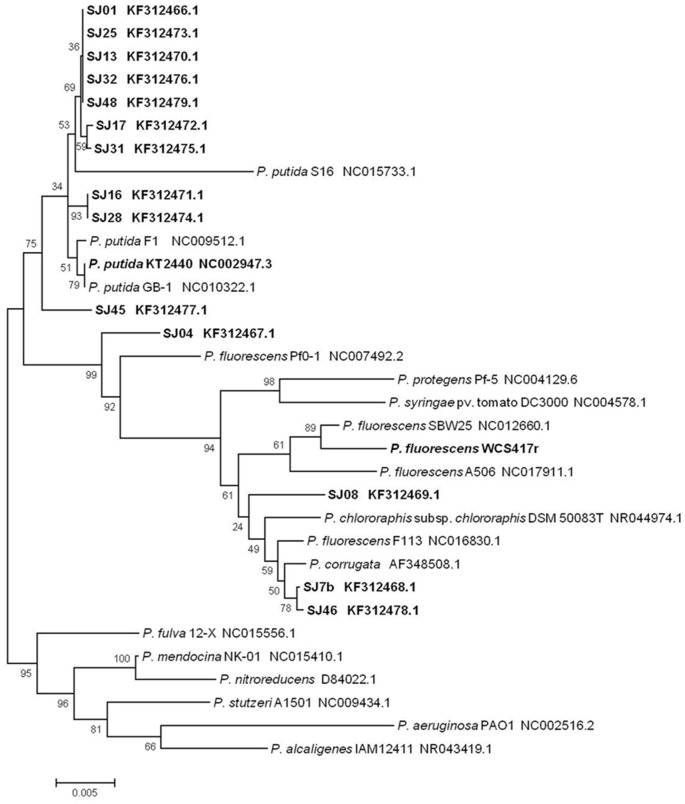
Phylogenetic tree of native and reference strains of fluorescent Pseudomonas based on aligned 16S rRNA sequences. Native strains isolated from the M. piperita rhizosphere are indicated by boldface. The tree was constructed based on multiple alignments and the neighbor-joining method, using the MEGA 4.0.2 software program. Bootstrap values on branches are shown as percentages from 1000 replications. Scale bar at bottom represents 5 nt substitution per 1000 nt sequences. GenBank accession numbers are shown.